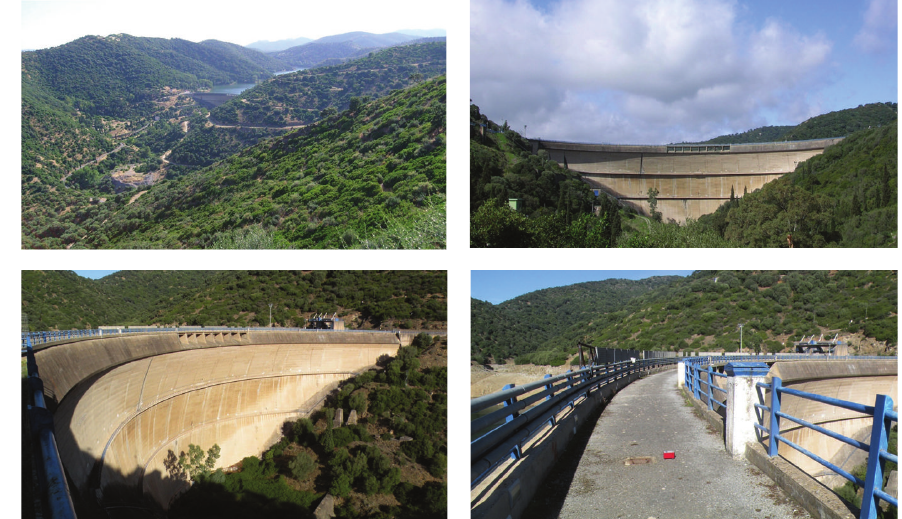
Figure 2: Some pictures of Punta Gennarta Arch Dam.